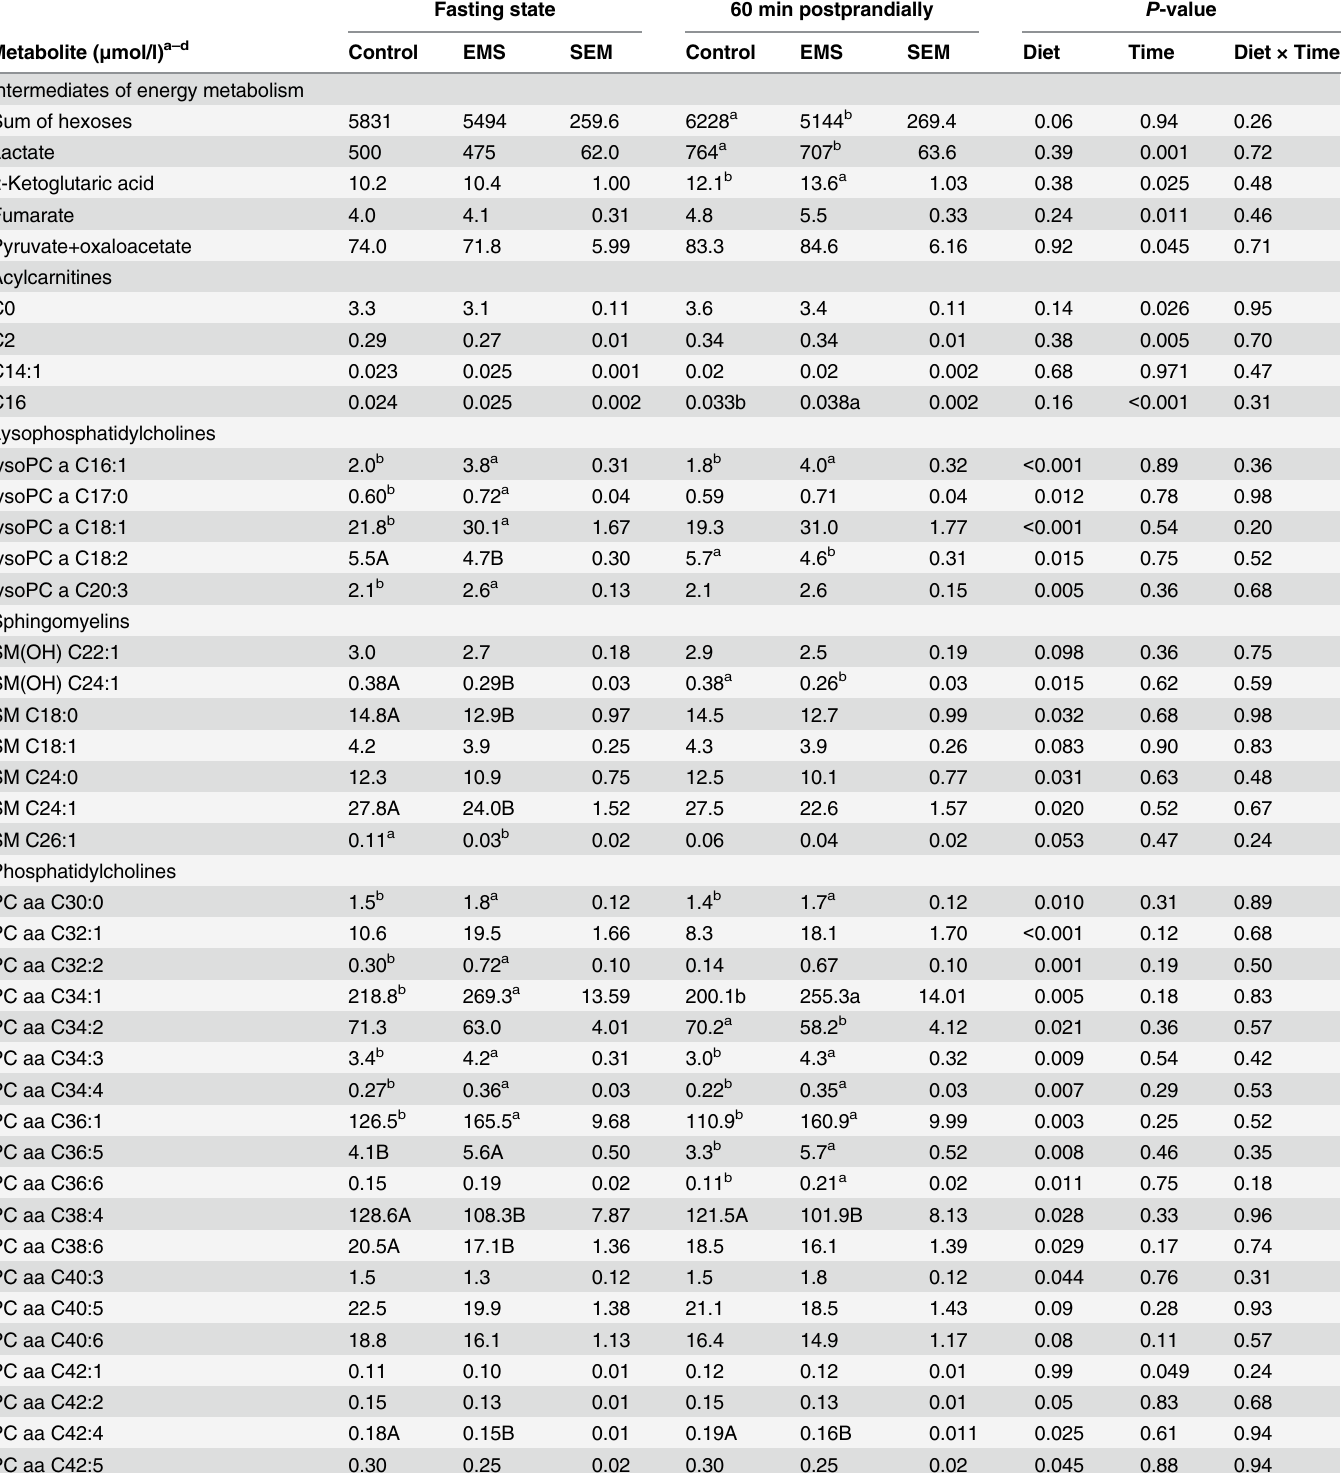
Table 3. Selected serum metabolite concentrations ( μ mol/l) of pigs fed the enzymatically modified starch (EMS) diet or control diet in the fasting state and at 60 min postprandially. Fasting state 60 min postprandially P